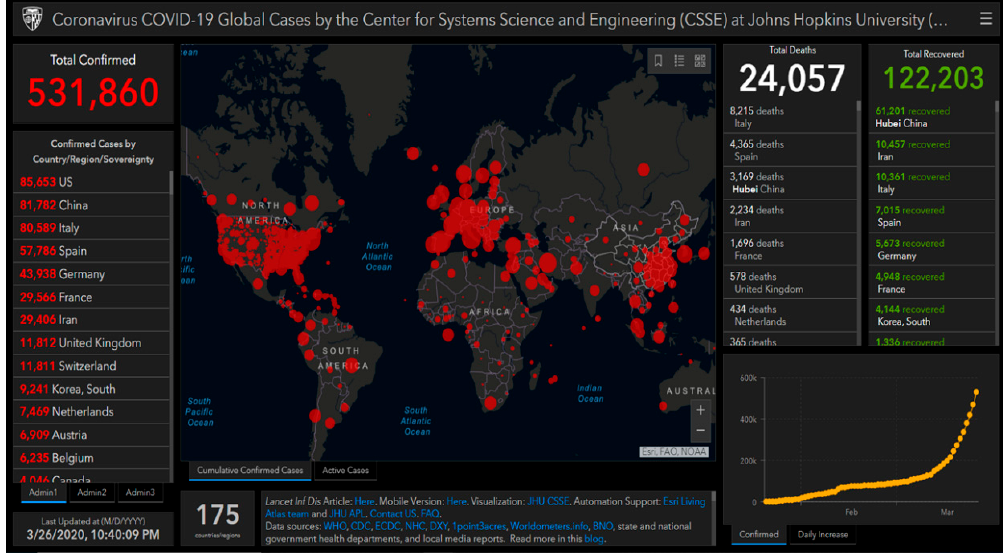
Figure 1. Status of worldwide confirmed cases of COVID-19 as of 26 March 2020 (Source: Johns Hopkins University [12,13]).